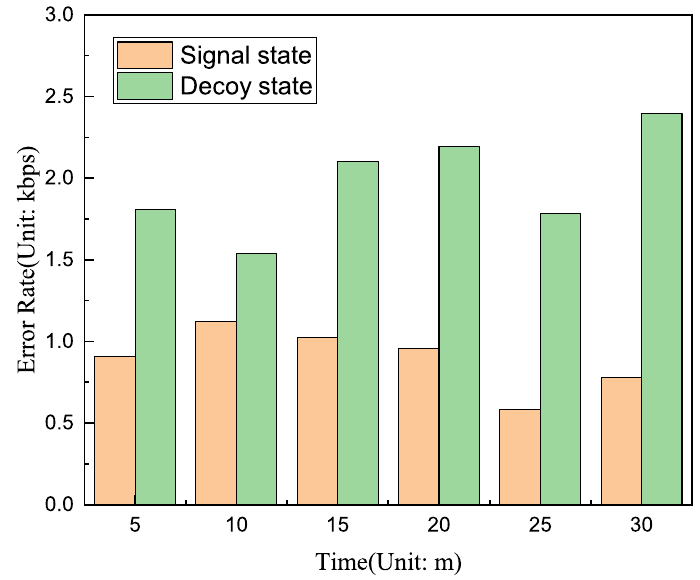
Figure 9. The quantum key error